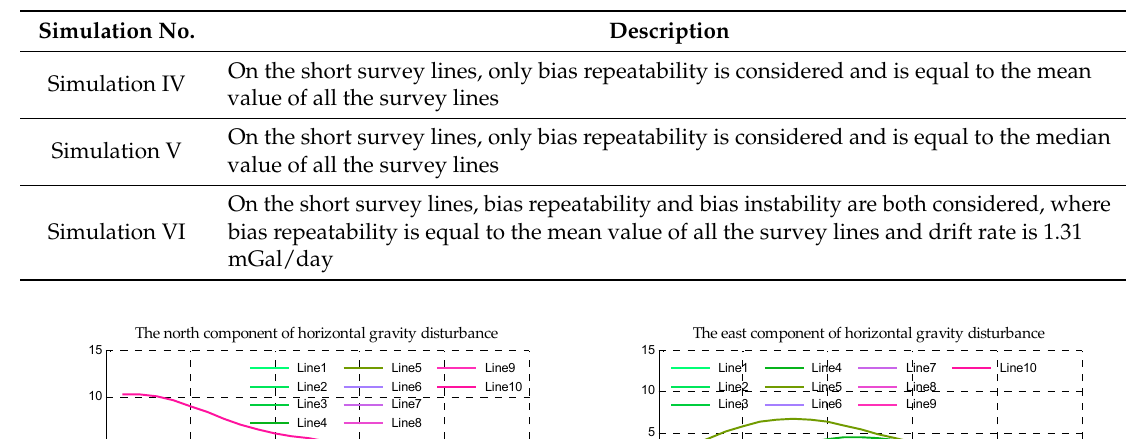
Table 5. Simulations on the short survey lines.